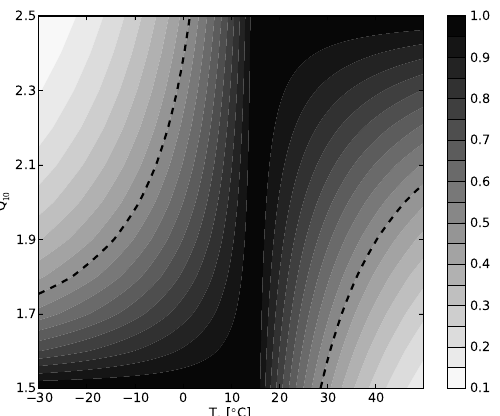
Figure 5. Values of f T as a function of T s and Q 10 . For each tem- perature, the value is expressed as the proportion of the maximum value achieved for any value of Q 10 . Areas outside of the dashed lines represent where f T is less than 50% of the maximum for the same